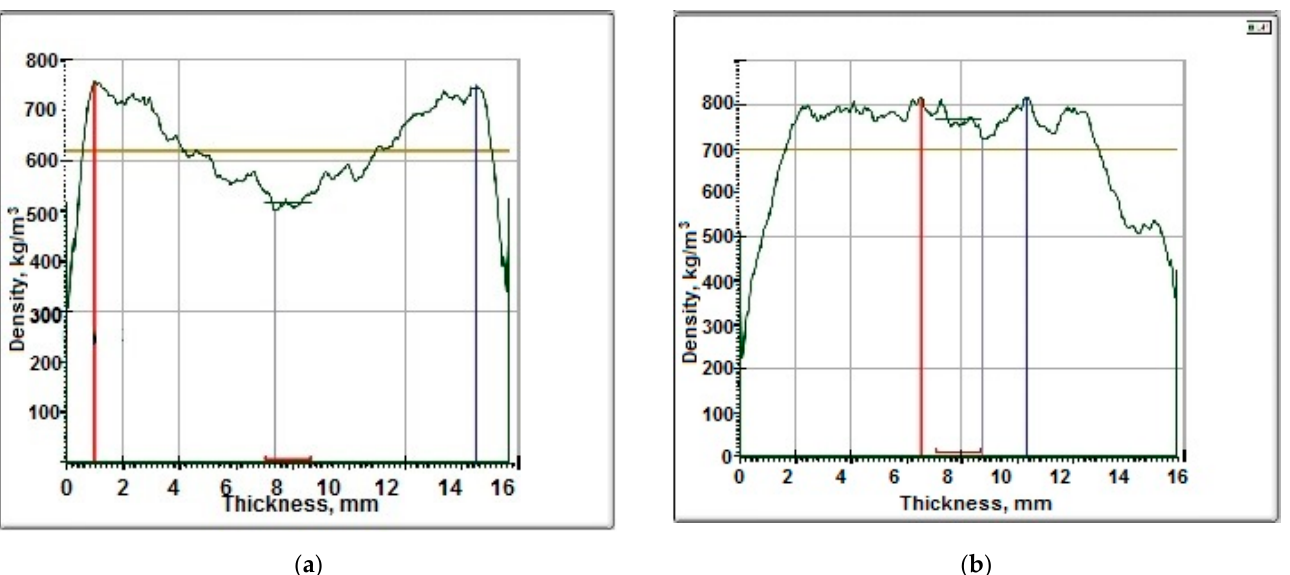
Figure 6. Panel density profiles along the panel thickness leading to very different board properties; ( a ) panel with oxidized lignin (LO20); ( b ) panel with oxidized lignin, 2% PMDI and glucose (PO 20 P2G).